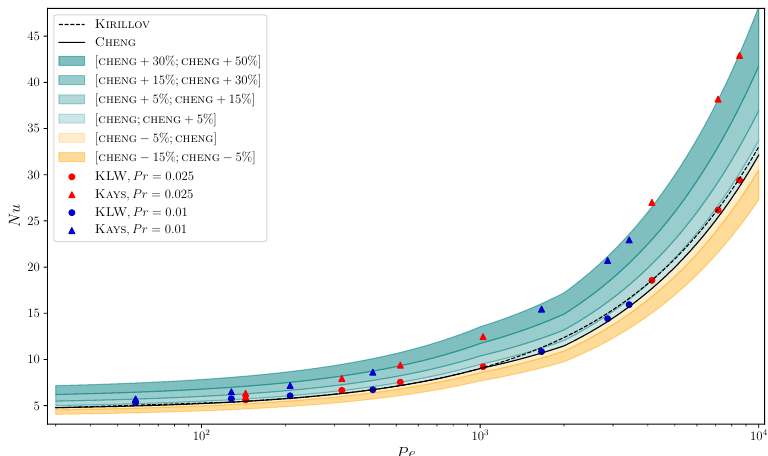
Figure 5. Cylindrical pipe tests. Nusselt number values for the simulations performed for fluids with Pr = 0.025 and Pr = 0.01 with the KLW and Kays [13] models. The values are compared with the Kirillov [33] and Cheng [4] correlations. Table 9. Cylindrical pipe tests. Numerical comparison of the KLW and Kays [13] models with Kirillov [33] and Cheng [4] correlations for Pr = 0.025 and 0.01. Reynolds Pr Source